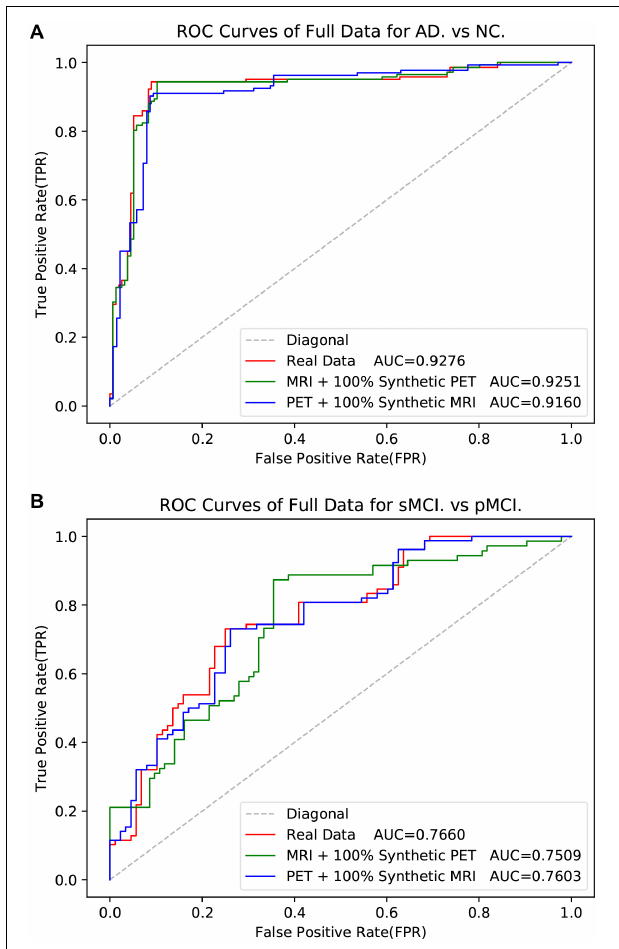
FIGURE 10 | The ROC curves in the experiment of classification with the full data.